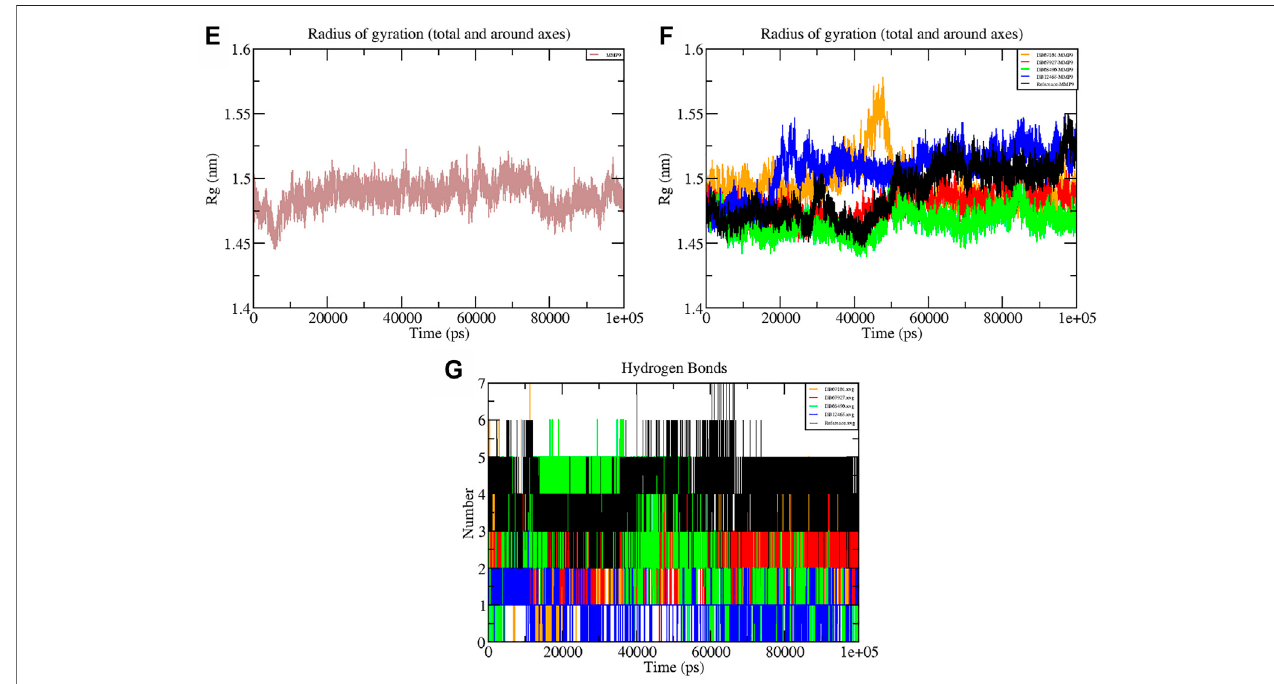
FIGURE 6 | Graphs representing the Rg of (E) MMP-9 (F) MMP-9 – ligand complexes (G) H-bonds during the 100 ns simulation period.